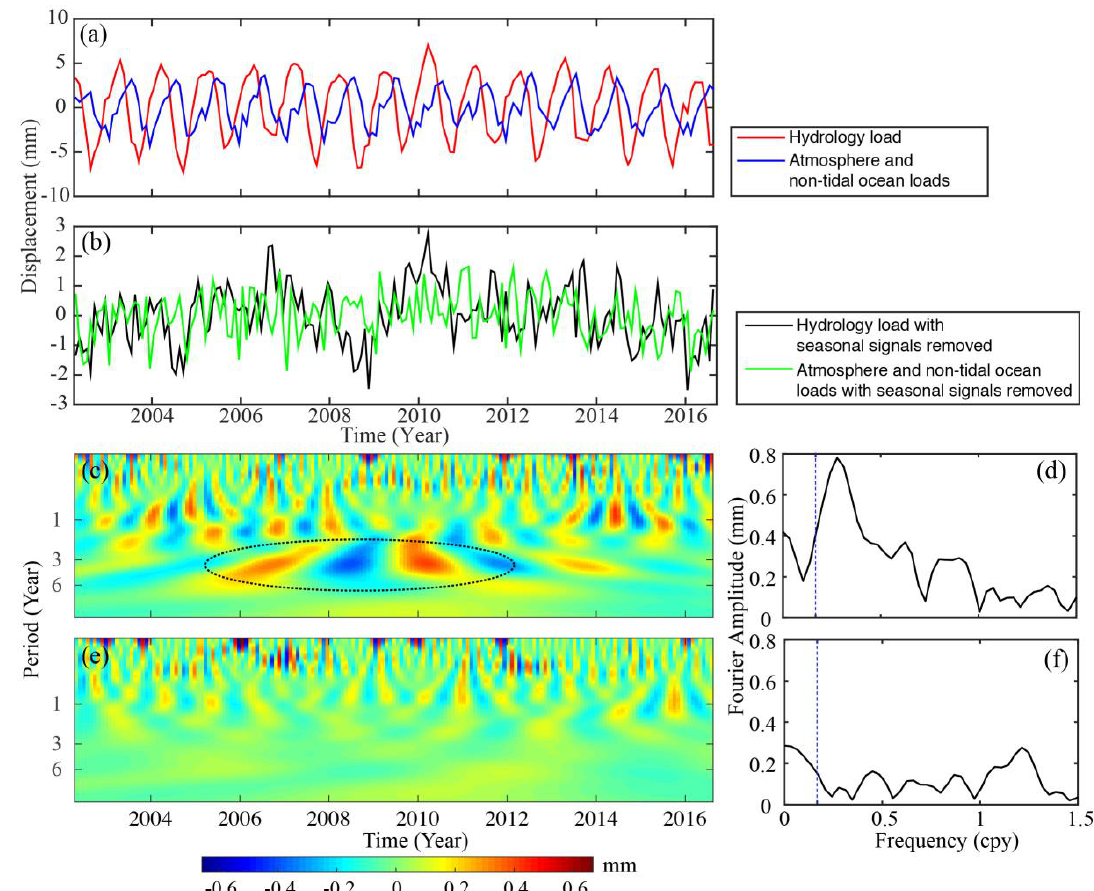
Figure 10. Vertical seasonal and interannual signals of atmospheric, hydrologic, and nontidal ocean loading displacements from GRACE-modeled mass changes corresponding to the locations of GPS sites in the ETP. ( a ) shows the average GRACE-modeled elastic displacements of hydrologic (GSM), atmospheric, and nontidal ocean (GAC) loads and ( b ) shows the corresponding elastic displacements with seasonal (annual and semiannual) signals removed (bottom). ( c ) and ( d ) are the wavelet time-frequency spectra and Fourier spectrum of GSM (seasonal signals removed). ( e ) and ( f ) are the wavelet time-frequency spectra and Fourier spectrum of GAC (seasonal signals removed).